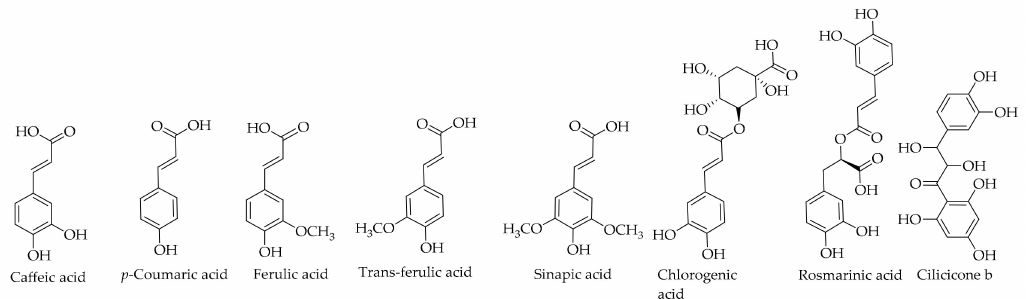
Figure 9. The chemical structures of di ff erent identified, isolated, and quantified hydroxycinnamic acids in the walnut green